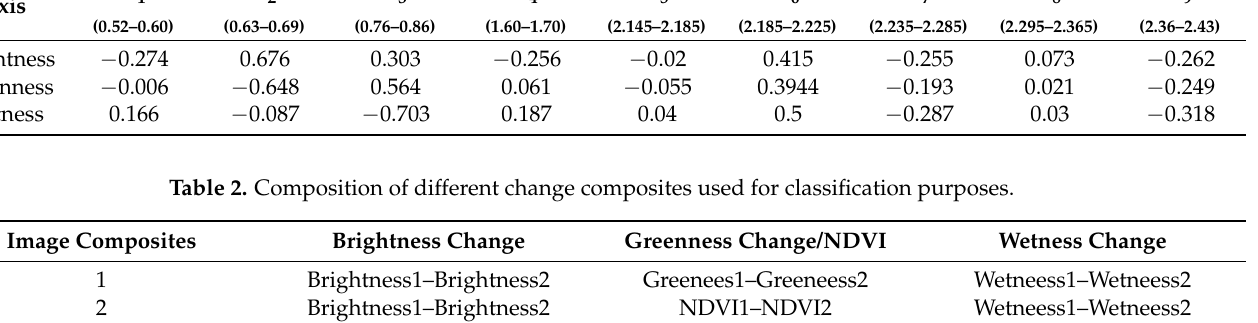
Table 1. Tasseled cap coefficients for TERRA-ASTER at-satellite reflectance with the spectral interval reported in brackets (in µ m) for each band. Axis